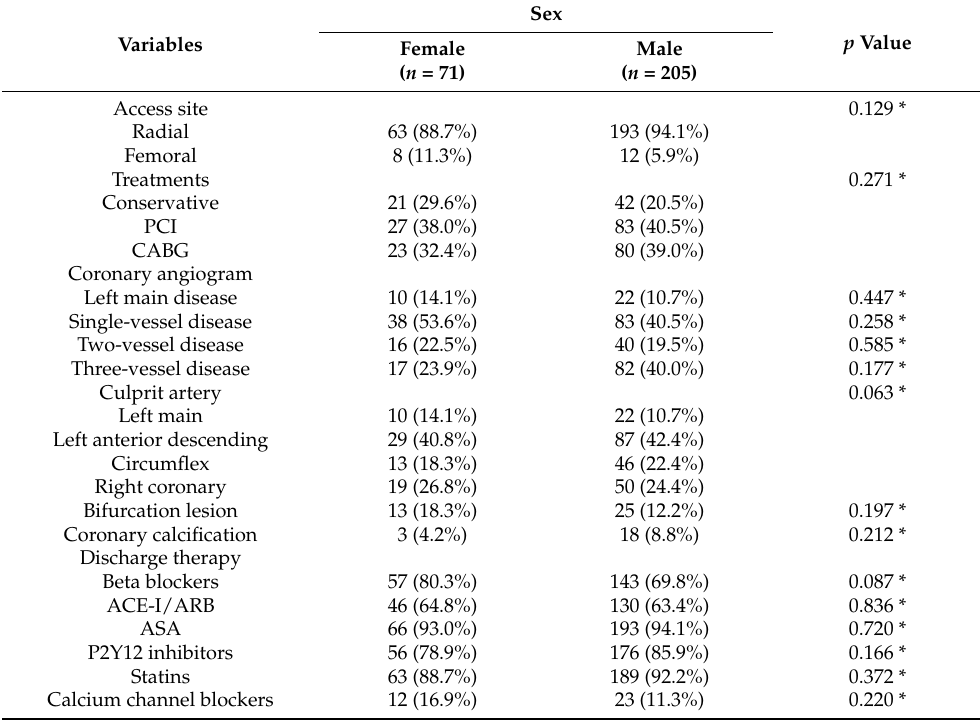
Table 2. Treatment and angiographic characteristics.